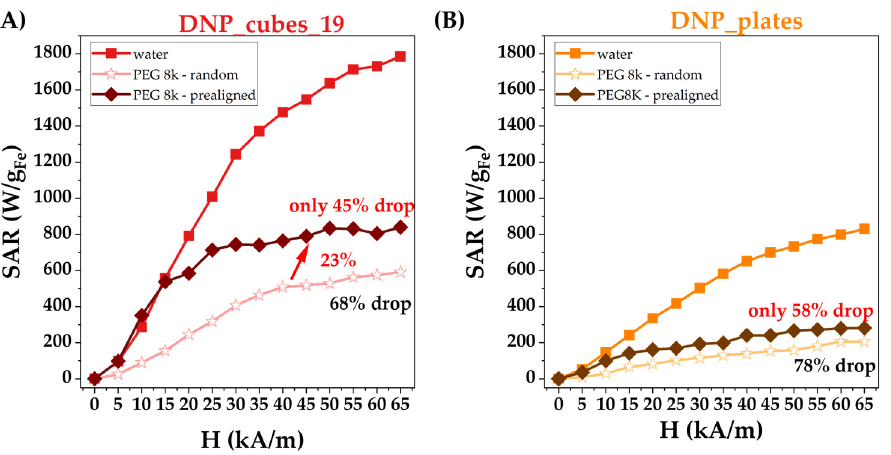
Figure 7. SAR values as a function of AMF in water and in the PEG 8 k matrix with and without prealignment using a magnet for ( A ) the DNP_cubes_19 suspension and ( B ) the DNP_plates suspension measured at 1 mg Fe /mL.